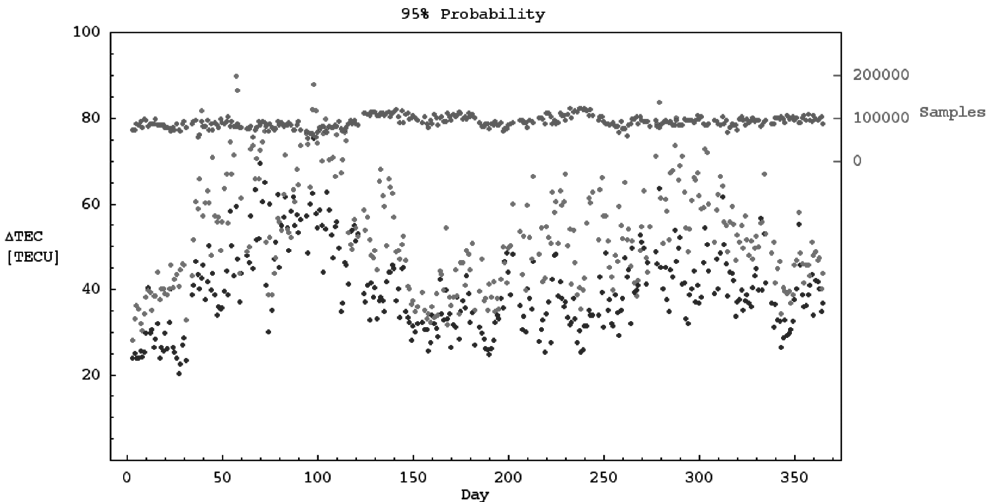
Fig. 3. 95 percentile (95% probability) of the cumulative distribution for global daily mis-modelling (difference between an experimental and its corresponding modelled slant TEC) for the ICA model (gray) and NeQuick 2 model (black). In the top part of the figure the corresponding samples used in each daily calculation is